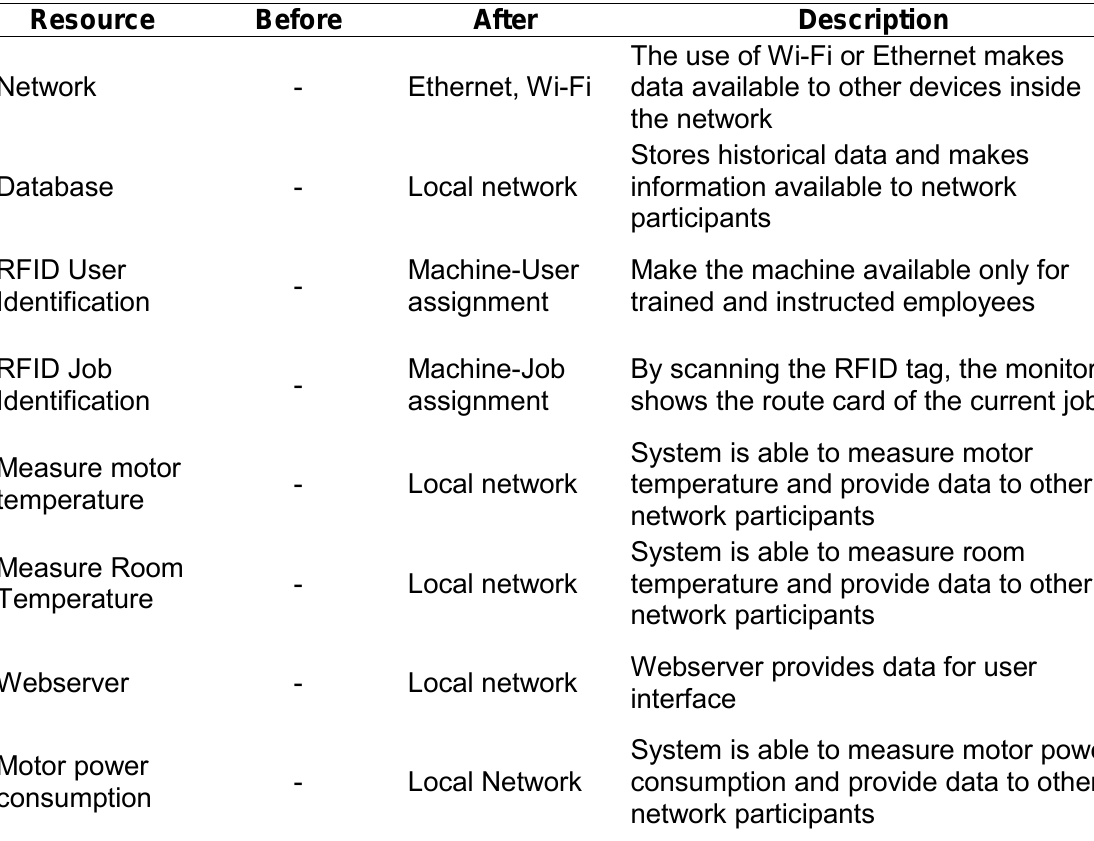
Table 1. Retrofitting